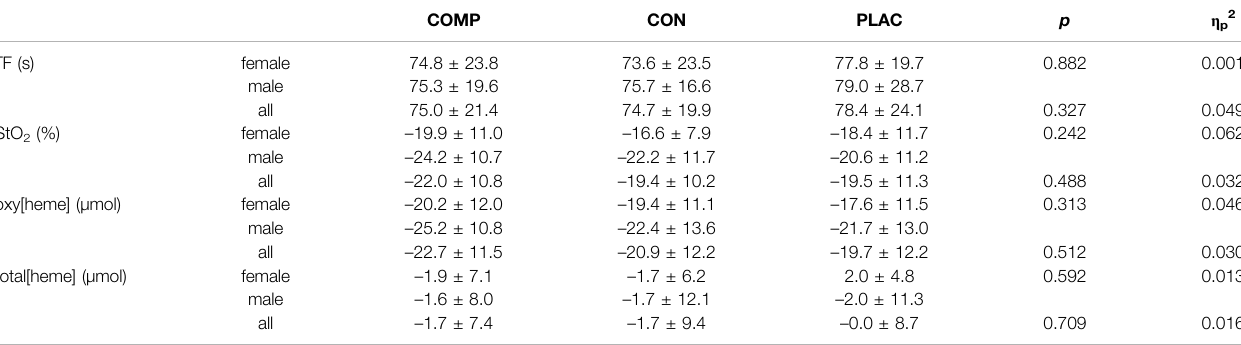
COMP CON PLAC p η p2